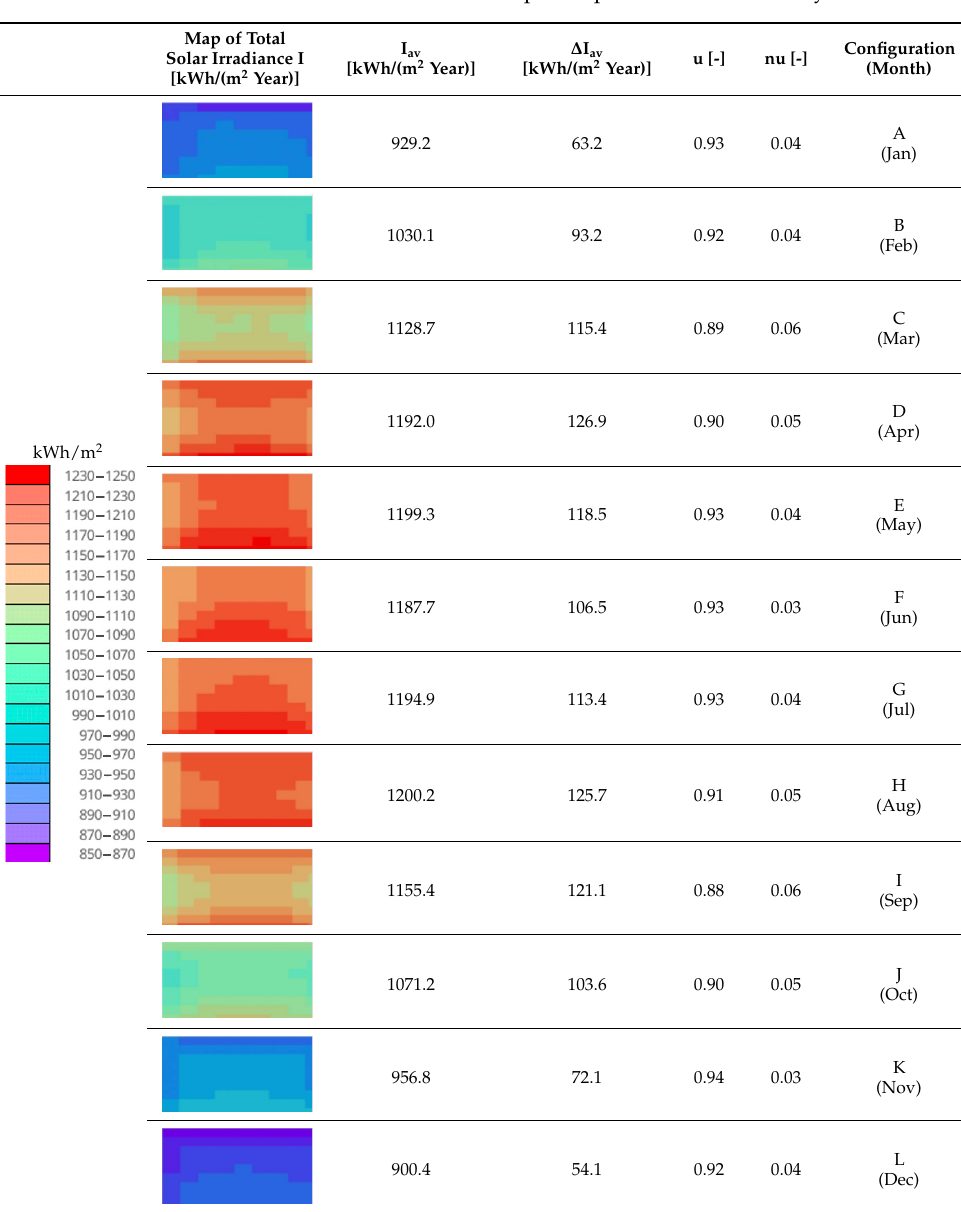
The cumulative monthly result of solar irradiance for each case is presented in Figures 4–6. The highest solar radiation intensity for reference and concentrating PV